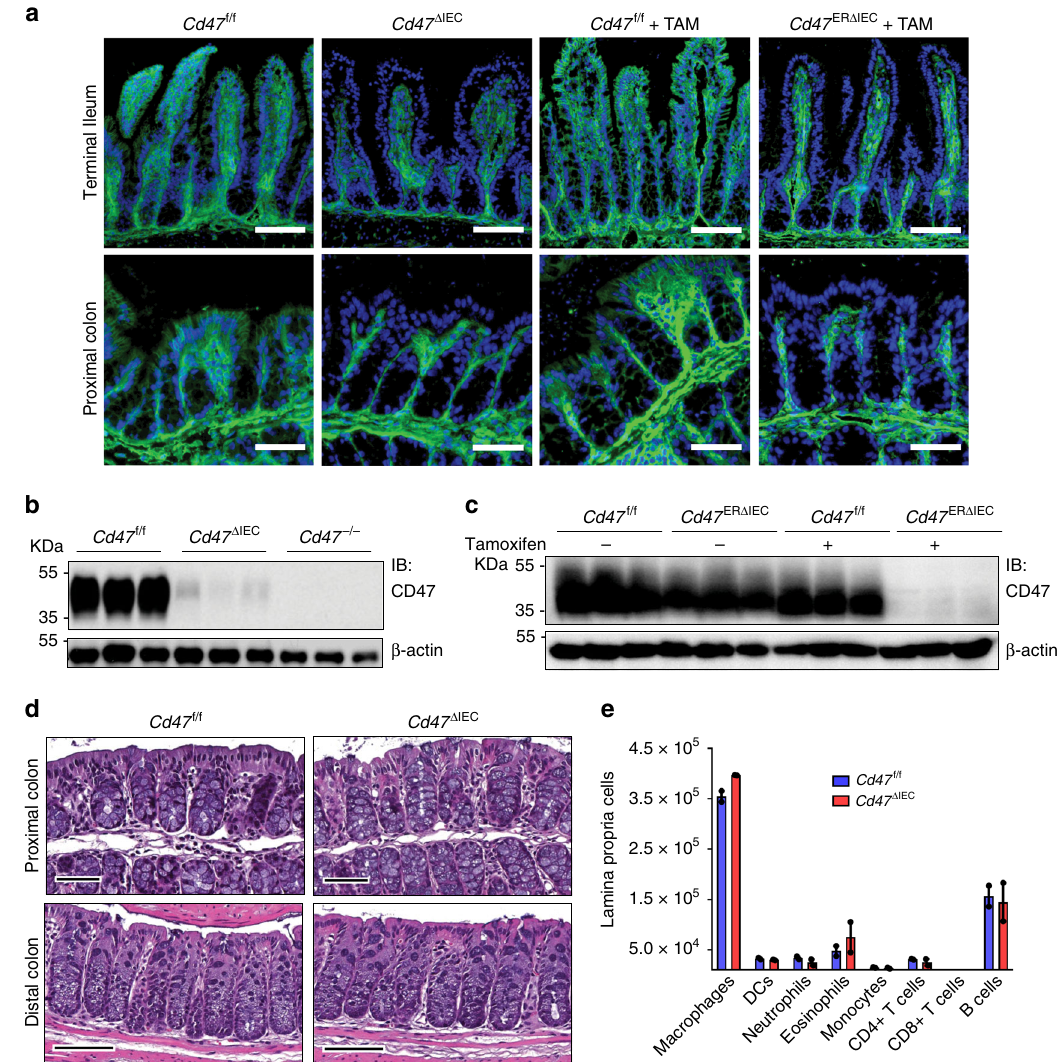
Fig. 2 Loss of CD47 in IEC does not induce immune-mediated mucosal damage. a – c Naive Cd47 Δ IEC and tamoxifen-treated Cd47 ER Δ IEC mice housed in pathogen-free conditions were analyzed for intestinal epithelial CD47 expression. Cd47 ER Δ IEC mice were treated with tamoxifen to induce acute CD47 deletion in intestinal epithelial cells, and analyzed 2 weeks later. a Tissue sections from naive Cd47 Δ IEC and tamoxifen-treated Cd47 ER Δ IEC mice were stained with anti-CD47 antibodies (green) with DAPI counterstain (blue). CD47 expression is absent in the epithelium but retained in the lamina propria and submucosa. Scale bars = 100 μ m upper panels, 50 μ m lower panels. b IECs were isolated from the terminal ileum of naive mice. Protein lysates were analyzed by SDS – PAGE and immunoblot for CD47. c IECs were isolated from Cd47 ER Δ IEC mice treated with vehicle (corn oil) or tamoxifen, and analyzed as in b . Results are representative of three independent experiments with 3 – 5 mice per group. d Paraf fi n-embedded colon tissue sections from Cd47 Δ IEC mice were stained with Hematoxylin and Eosin counterstain for histological examination. Gross mucosal architecture is intact in the absence of epithelial CD47 expression. Scale bars = 50 μ m upper panels, 100 μ m lower panels. e Colon tissue digests from naive Cd47 Δ IEC mice were stained and analyzed by fl ow cytometry, showing no signi fi cant differences in major lamina propria immune cell populations. Points represent individual samples each containing two mice ( n = 4 mice per group). Data are means ± SEM and are representative of three independent experiments. Source data are provided as a Source Data fi cycles of DSS and water administration revealed signi fi cantly worse mucosal injury and less repair in Cd47 Δ IEC mice and tamoxifen-treated Cd47 ER Δ IEC mice, with increased crypt loss and mucosal ulceration evident in the distal colon (Fig. 4c – e). PMN/ granulocytes were visualized in the in fl amed colonic mucosa of both genotypes with prominent accumulations of PMN observed in Cd47 Δ IEC mice (Supplementary Fig. 2). These fi ndings indicate that loss of CD47 results in impaired mucosal recovery associated with persistent in fl ammation in Cd47 Δ IEC mice in response to chronic DSS. In contrast, acute DSS treatment without recovery period did not produce statistically signi fi cant disease differences